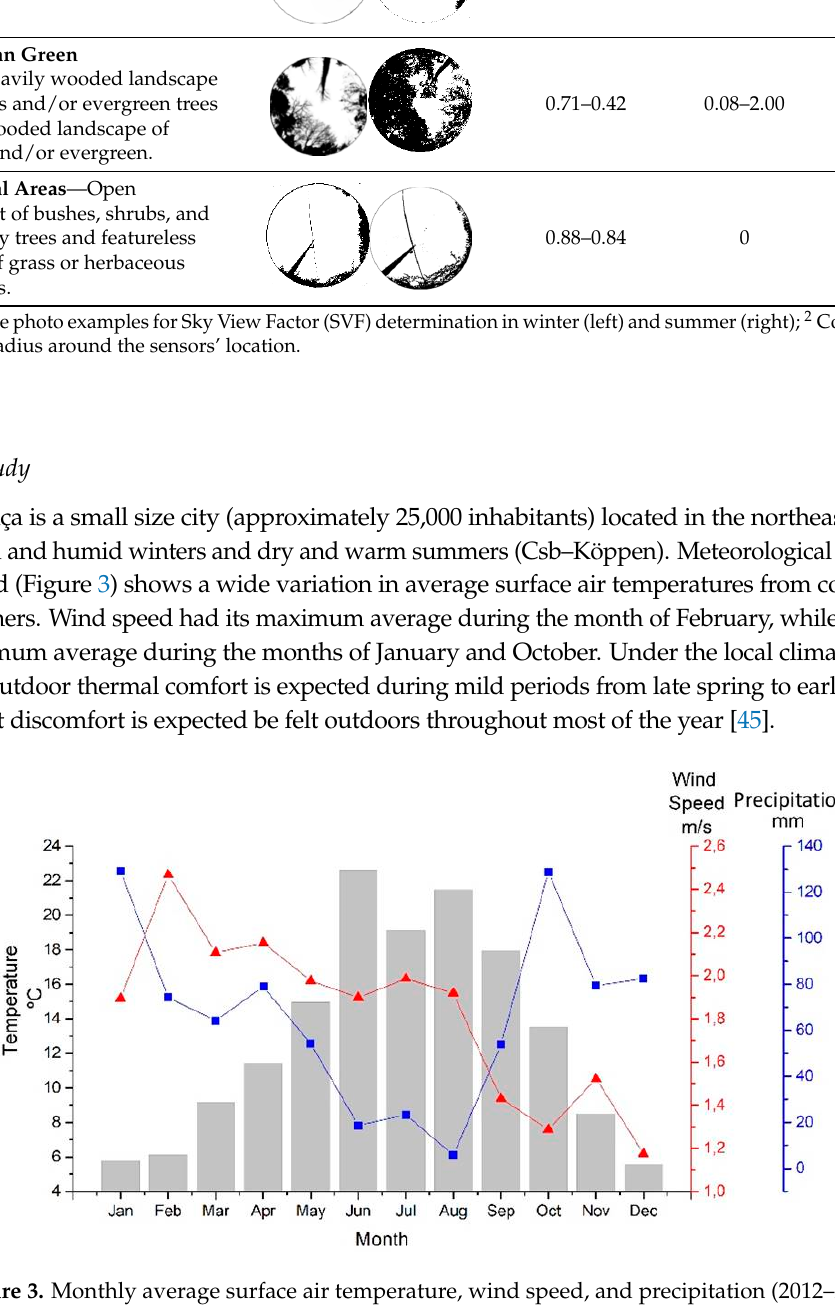
Figure 3. Monthly average surface air temperature, wind speed, and precipitation (2012–2016). A